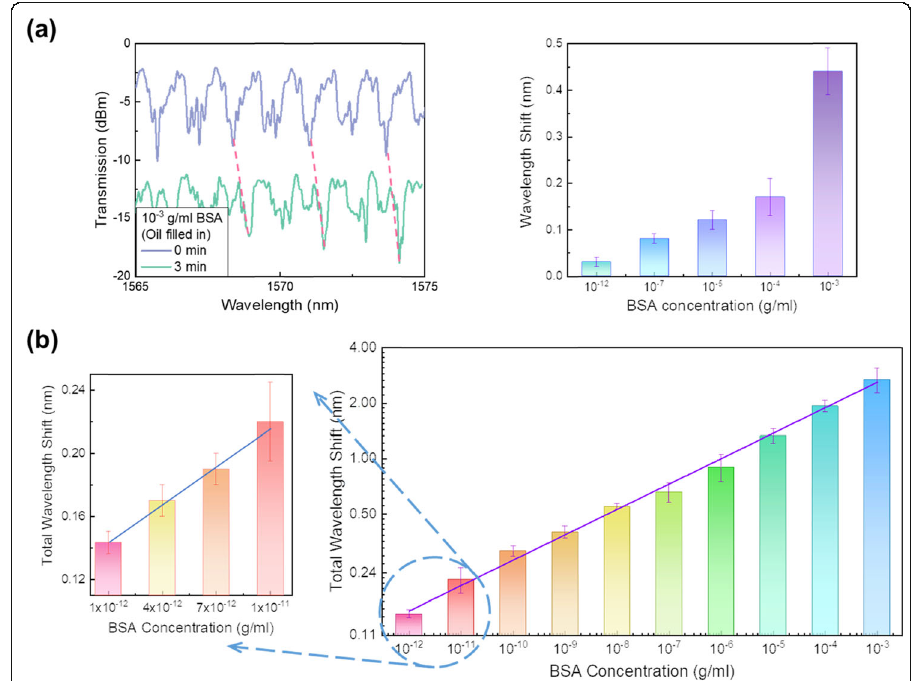
Fig. 4 ( a ) Oil was filled in resonator to study the effect of BSA absorption behavior on WGM spectral wavelength shift. The WGM spectral responses at 10 − 3 g/ml BSA (left panel) showed only red-shift tendency and the overall wavelength shift under several BSA concentrations was shown in right panel. ( b ) The overall wavelength shift responses from WGM laser spectra under various BSA concentrations (from 10 − 12 to 10 − 3 g/ml) are calculated by summing up the blue shift distance and the red shift distance. The left panel exhibits the corresponding wavelength responses at various extremely low BSA concentrations (10 − 12 , 4 × 10 − 12 , 7 × 10 − 12 and 10 − 11 g/ml). According to the calibration curve, the limit of detection for BSA is 1.92 fM (1.28 × 10 − 13